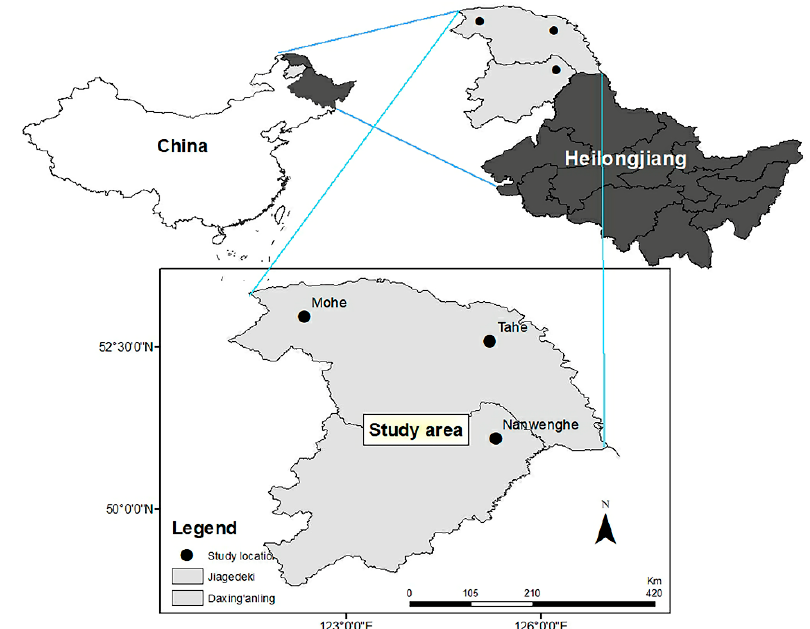
Figure 1. Map of the study region.